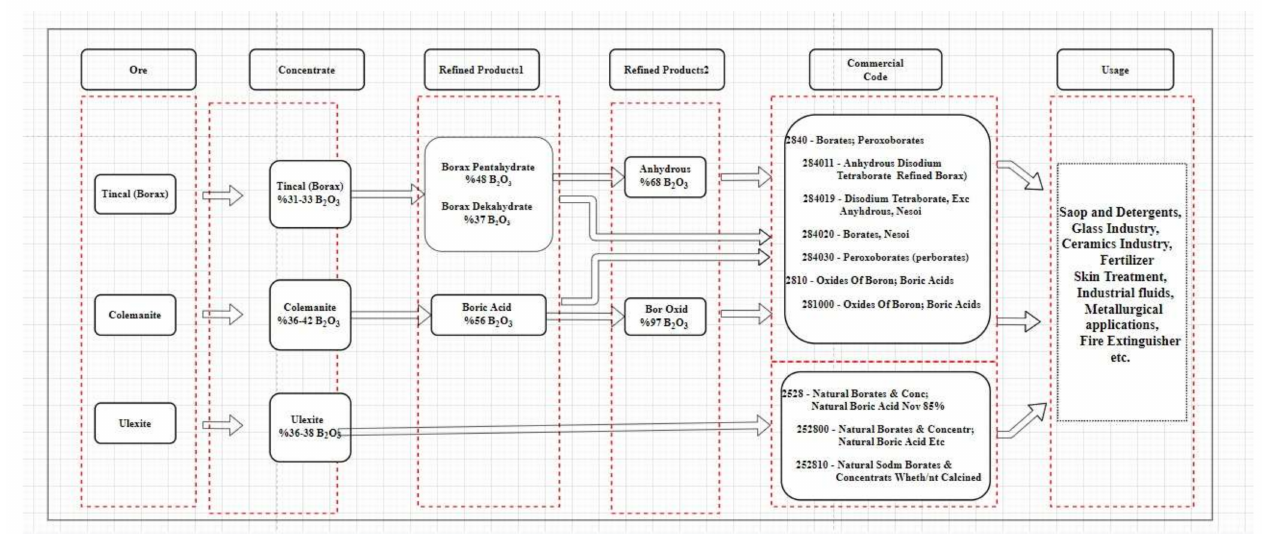
Figure 1. Flow of Boron minerals to usage area.